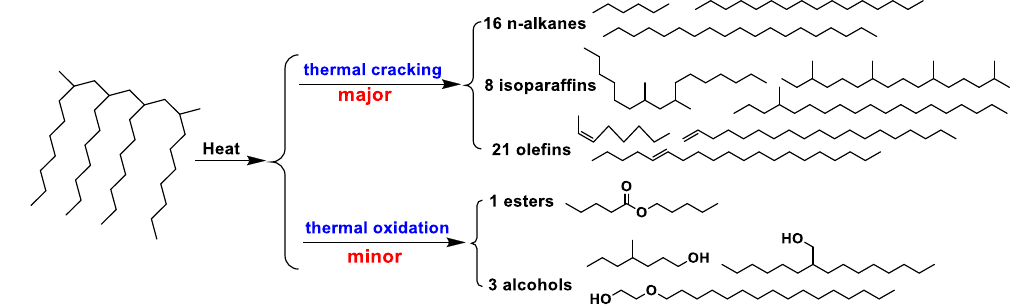
Figure 11. Possible reaction types of PAO.